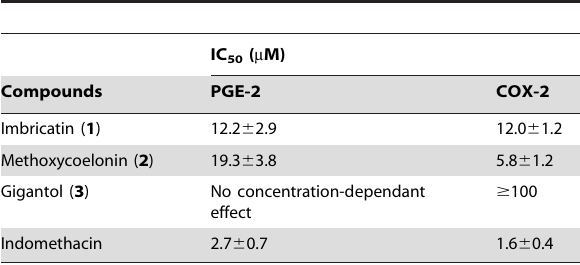
Table 3. Effects of stilbenoids 1–3 on inhibition of HaCaT PGE-2 production and COX-2 enzyme